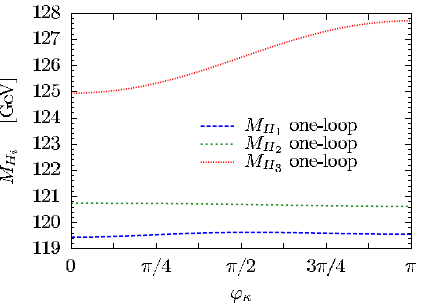
Figure 2. The one–loop masses for the H 1 , H 2 and H 3 states for a C –NMSSM scenario without tree–level CP violation. The figure has been taken from Ref.